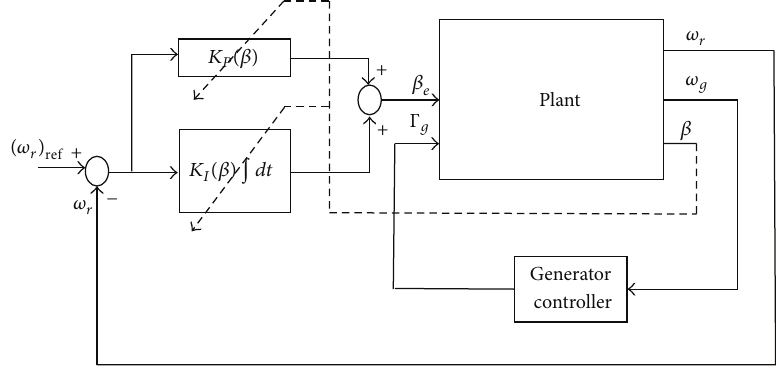
Figure 10: Implementation structure for gain scheduling PI